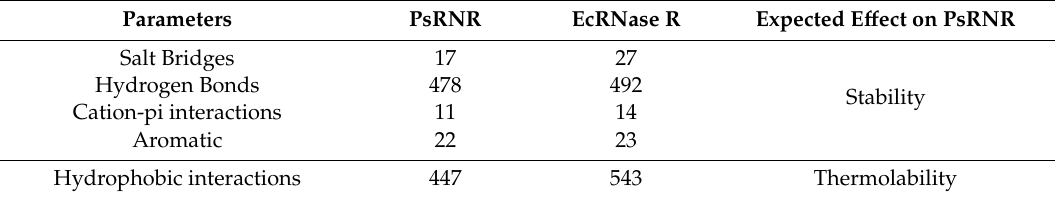
Table 1. Comparison of structural adaption features between PsRNR and its homolog (EcRNase